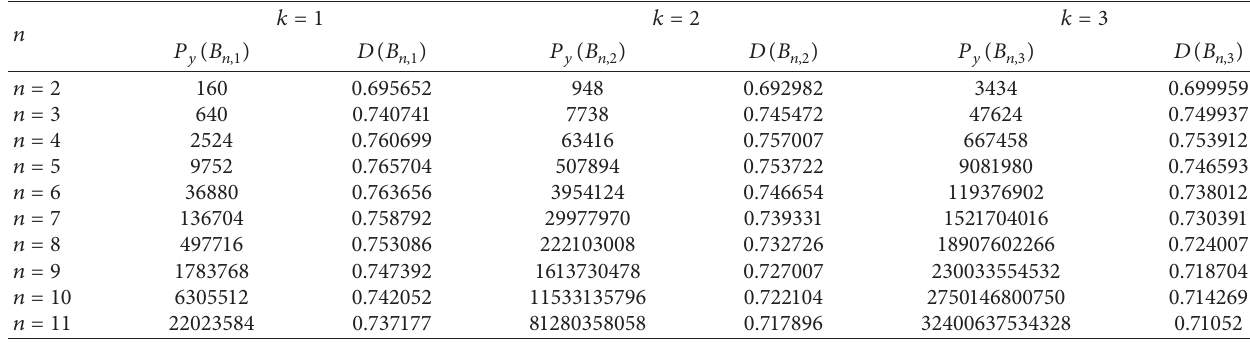
( n � 2 , 3 , ... , 11 ; k � 1 , 2 , 3 ) n,k